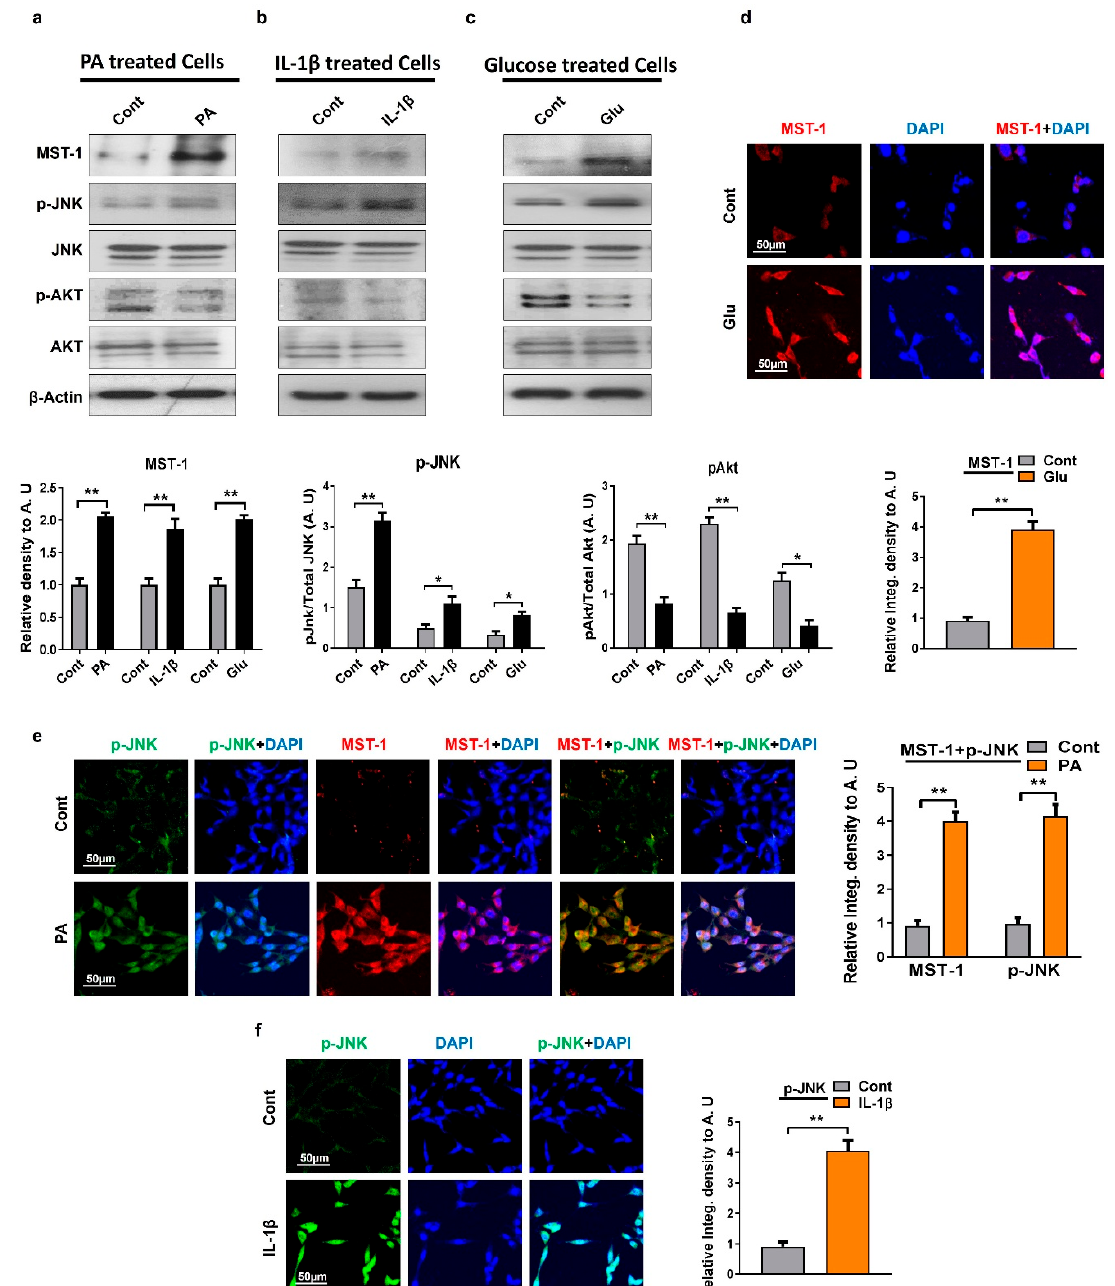
Figure 2. Metabolic dysfunctions regulate the expression level of MST1, p-JNK, and p-AKT in HT22 cells: ( a – c ) Western blot analysis of MST1, p-JNK, and protein kinase B (p-AKT) in palmitic acid, IL-1 β , and glucose treated HT22 cells. The bands were quantified using ImageJ software, and the di ff erences are depicted in the respective histogram. β -actin was used as a loading control. ( d ) Representative images of immunofluorescence staining showing MST1 expression in glucose-treated cells; ( e ) double immunofluorescence images of p-JNK and MST1 in palmitic acid treated HT22 cells; ( f ) representative immunofluorescence results of p-JNK expression in IL-1 β treated HT22 cells. The data are shown here as a mean ± SEM. * p < 0.05, ** p < 0.01.